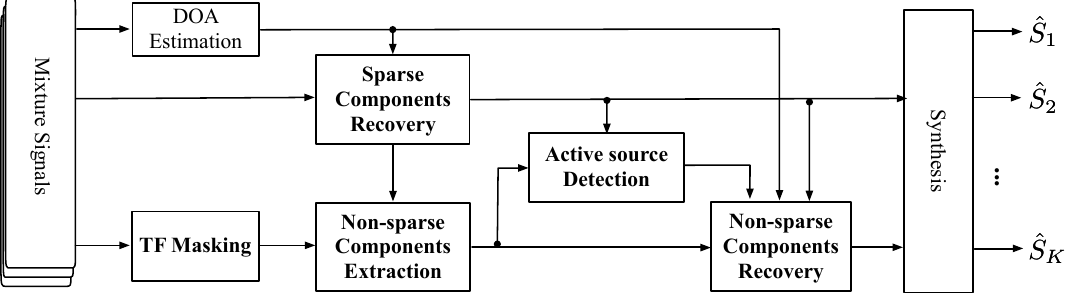
Figure 3. System block diagram of the proposed method. DOA: direction of arrival; TF: